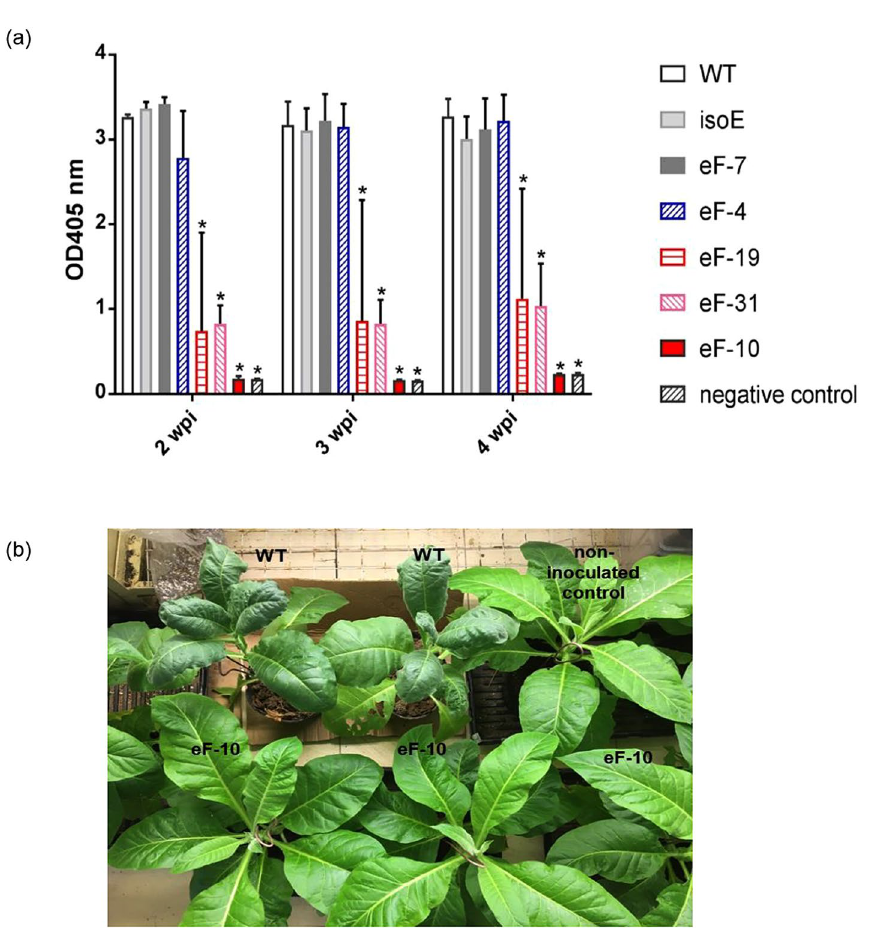
Figure 4. Effect of eIF4E/eIF(iso)4E mutations on PVY accumulation in T0 tobacco plants. ( a ) PVY O accumulation in the systemic leaves of infected plants was assessed by DAS-ELISA at 2, 3 and 4 weeks post- inoculation (wpi); WT wild type plant, isoE eIF(iso)4E-S and eIF(iso)4E-T double mutant line, eF-7 eIF4E2-S and eIF4E2-T double mutant line, eF-4 eIF4E1-T mutant line, eF-19 eIF4E1-S mutant line, eF-31 eIF4E1-S and eIF4E1-T double mutant line; eF-10 eIF4E1-S , eIF4E1-T , eIF4E2-S and eIF4E2-T quadruple mutant line; negative control: non-inoculated plant; Mean and standard errors of 405 nm absorbance (A405) values were calculated for 5 independent plants per line, *P < 0.05 versus corresponding positive control (WT). ( b ) PVY O -infected Nicotiana tabacum K326 plants at 10